Question: What type of chart is this?
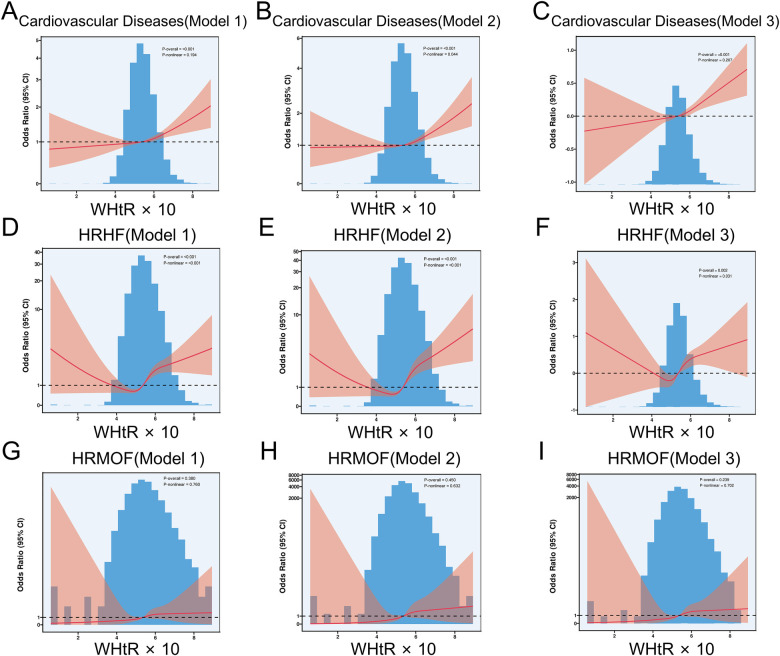
Answer: line